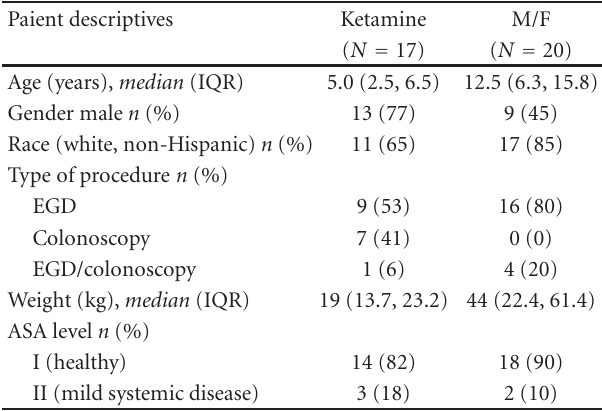
Table 1: Results: Patient demographics by sedation